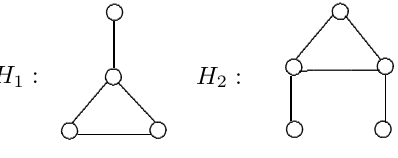
Figure 2: The graphs H